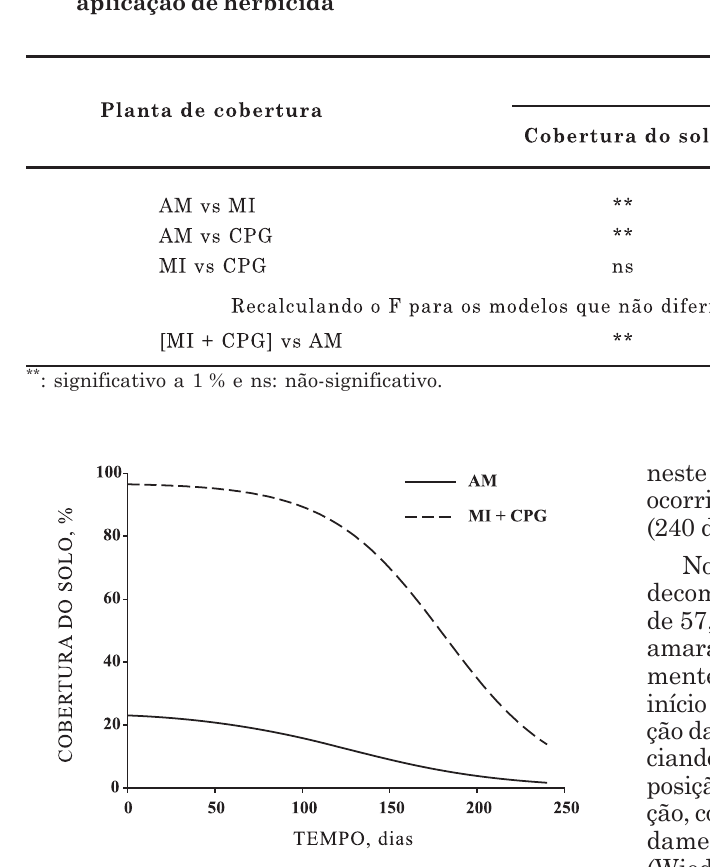
Figura 1. Cobertura do solo promovida pela palhada remanescente dos resíduos culturais de amaranto (AM), milheto (MI) e capim-pé-de- galinha (CPG), ao longo do tempo, após aplicação de